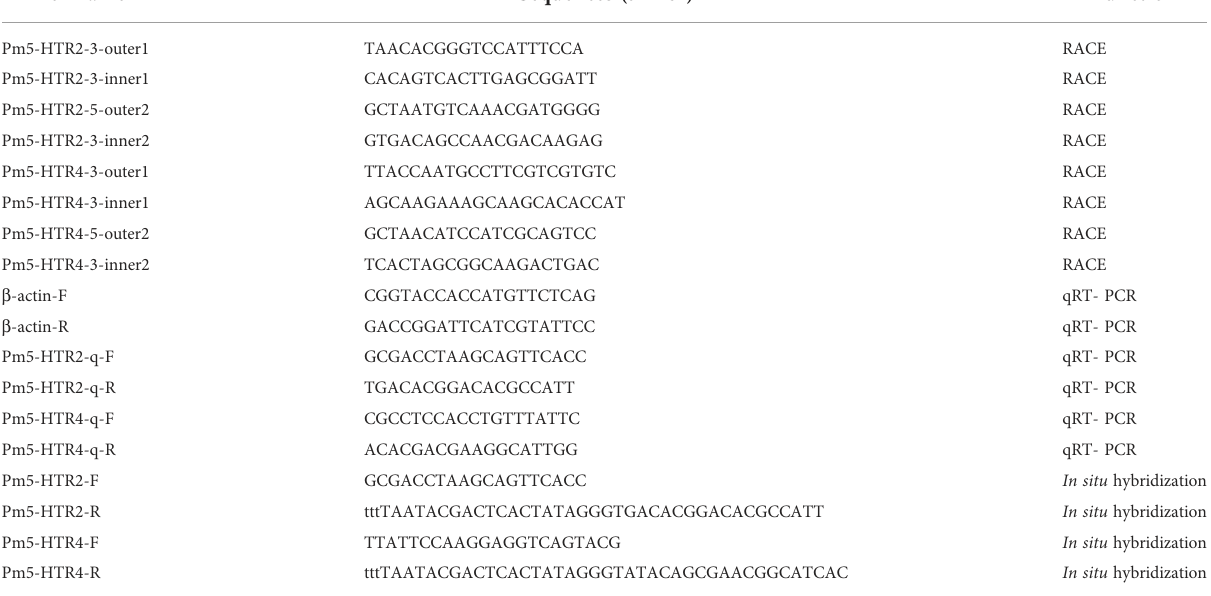
TABLE 1 Primers used in the present